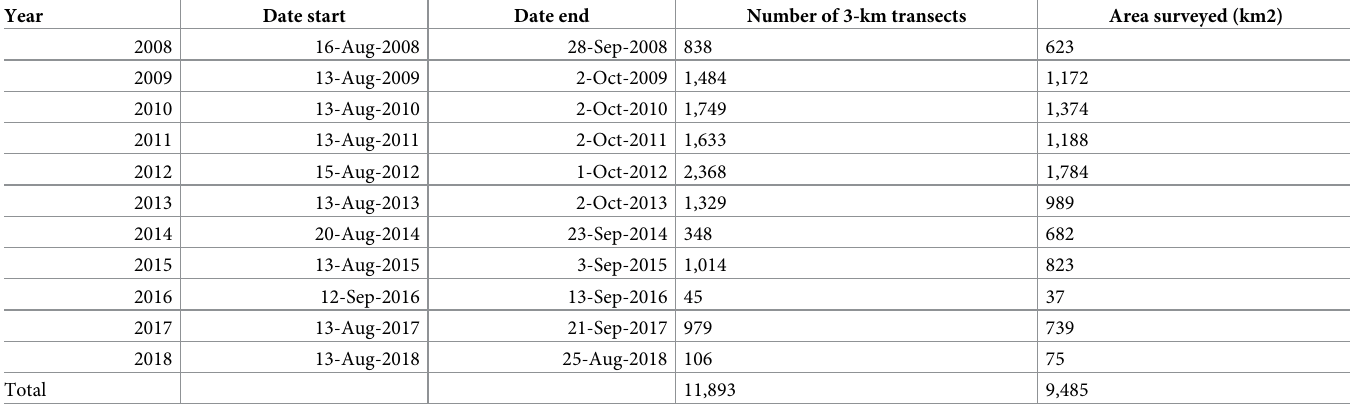
Table 1. Sampling effort by year, northeastern Chukchi Sea,